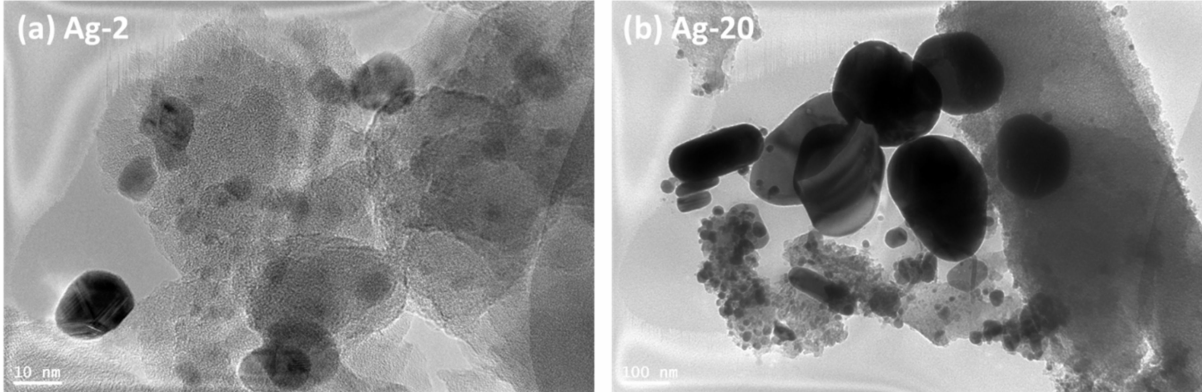
Figure 3. SEM micrographs of the prepared silver nanoparticles supported on amorphous bio-based silica samples.